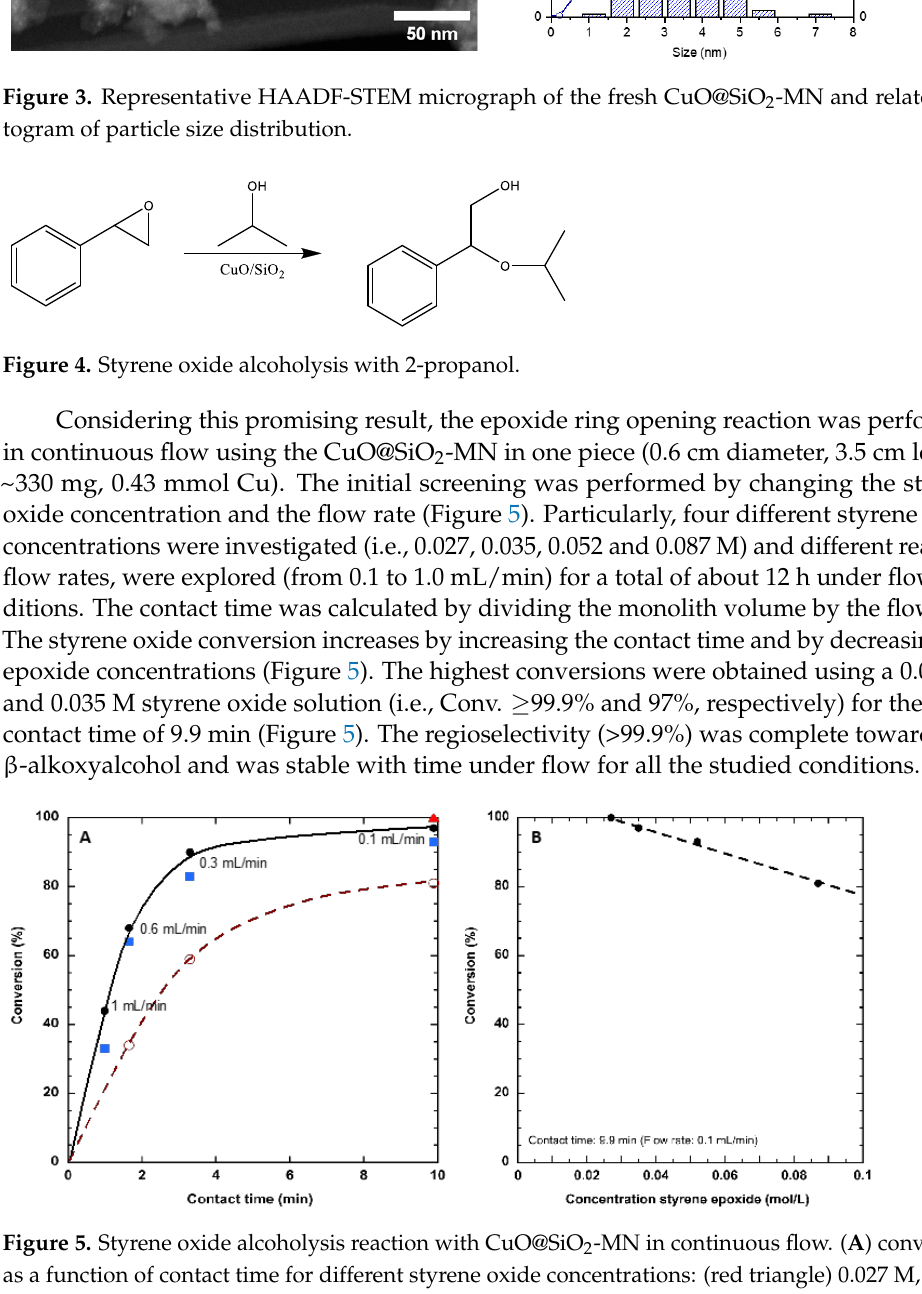
points) 0.035 M, (blue square) 0.052 M, (red circle) 0.087 M; ( B ) conversion as a function of styrene